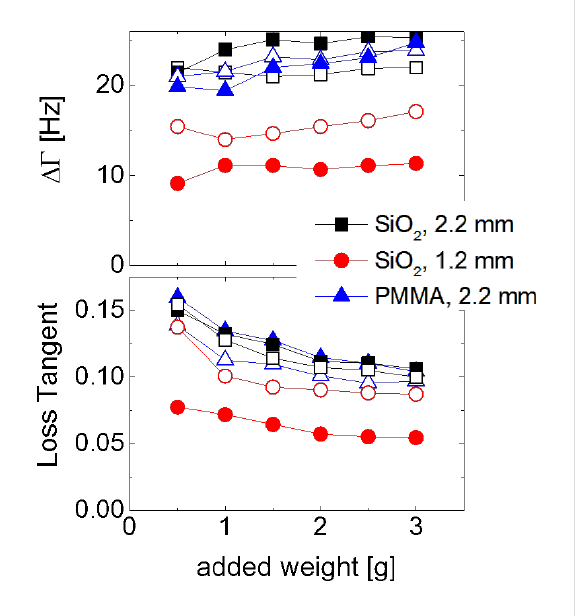
Figure 7: Shift in bandwidth, ΔΓ (top) and loss tangent, ΔΓ / Δ f , (bottom) in the low-amplitude limit. Full and open symbols denote measure- ments in air and water, respectively. The fact that ΔΓ is a constant independent of the normal load, suggests interfacial processes as the source of dissipation. If the dissipation were to occur in the material, one would expect the loss tangent to be constant, rather than ΔΓ itself, because a materials parameter should not depend on the normal load.